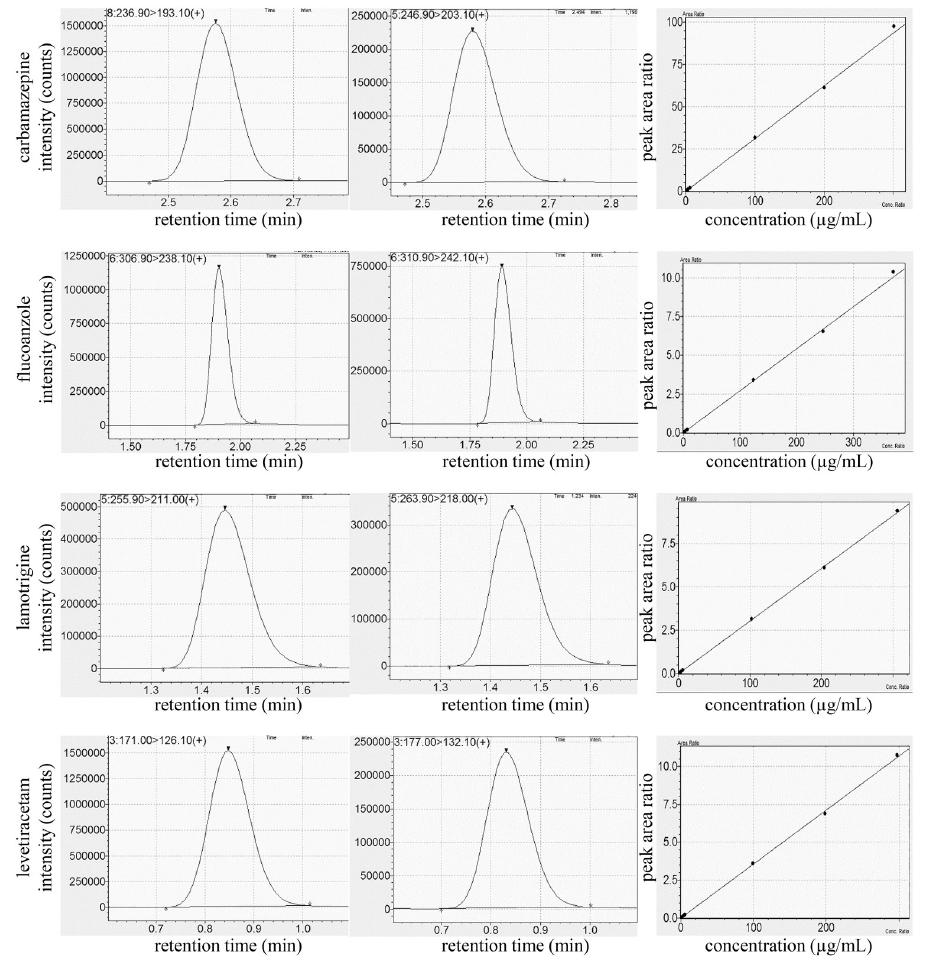
Fig 3. Representative analytical data. Ion chromatograms of the analytes (left) and the internal standards (middle), and representative calibration curves (right) obtained in the experiments.